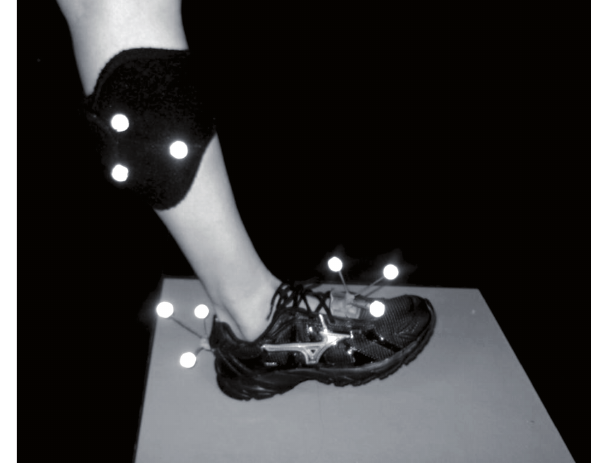
Figura 1 - Coleta estática com o indivíduo descalço Fonte: Dados da pesquisa.